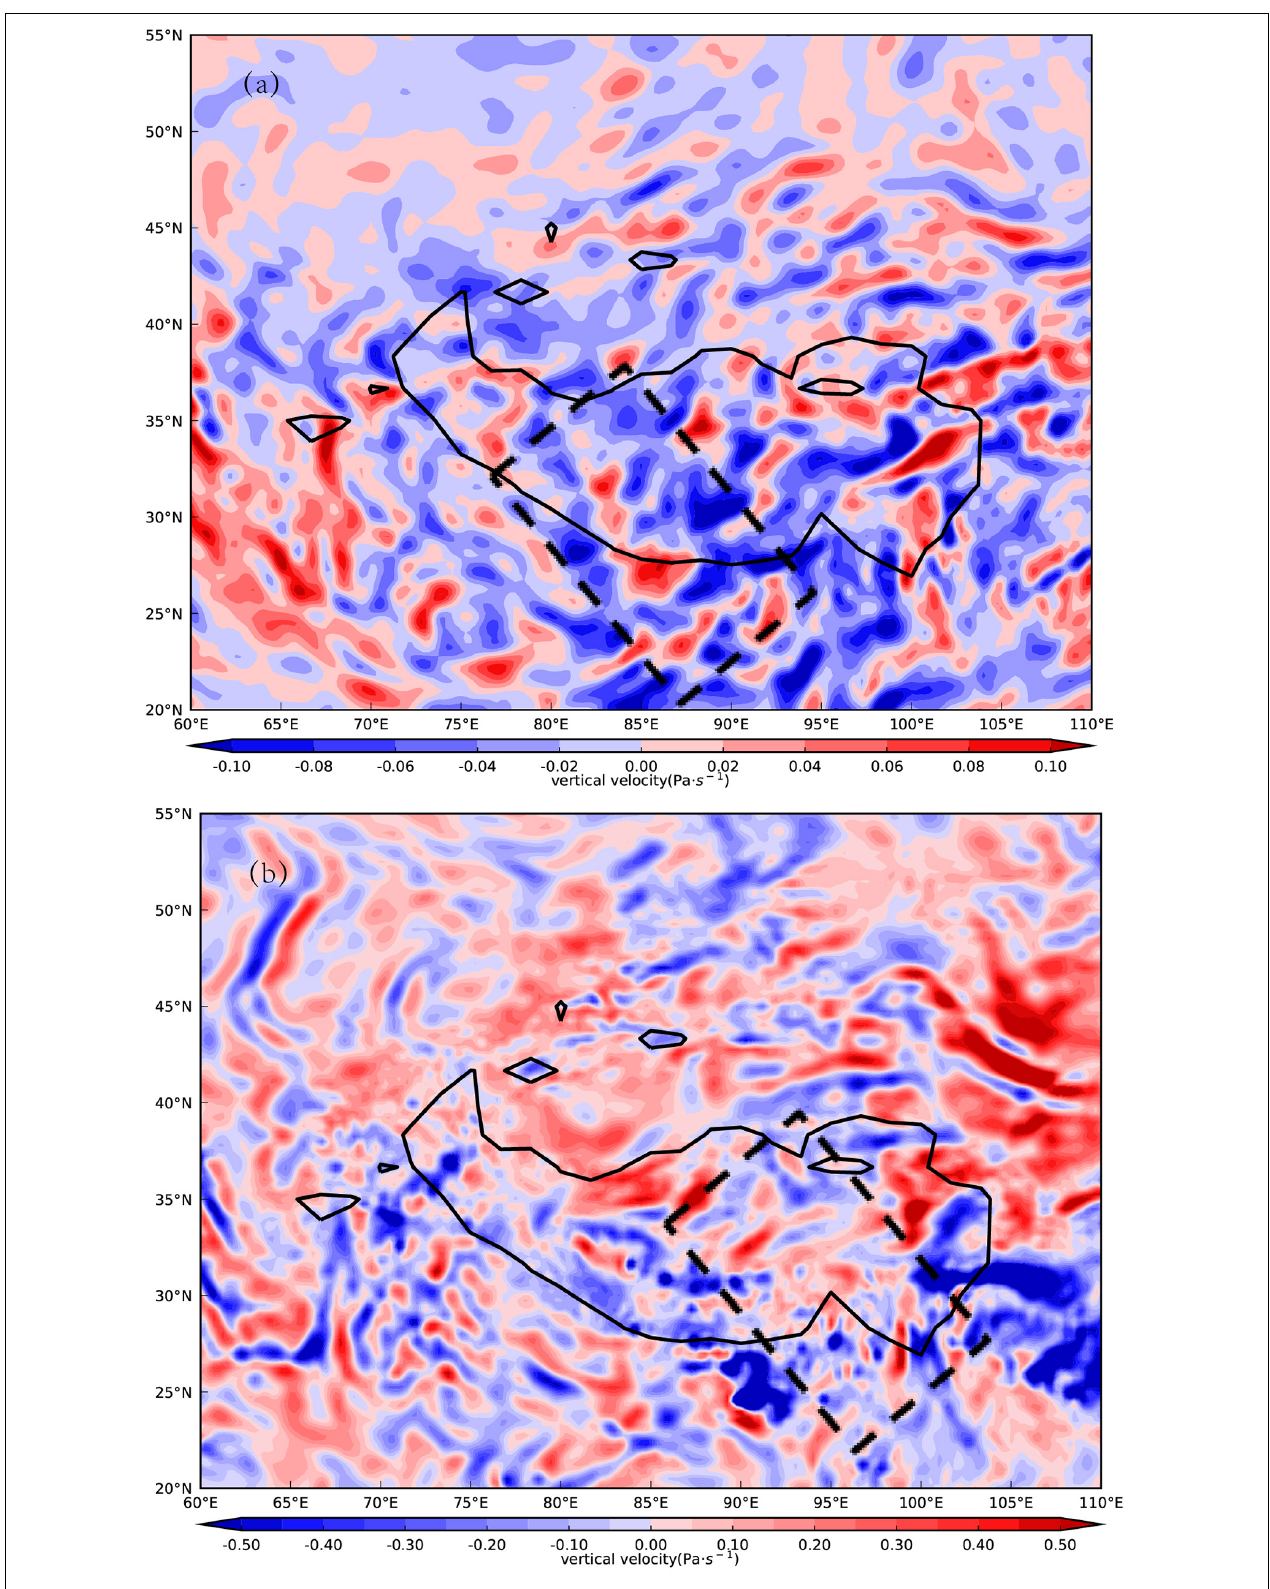
FIGURE 2 | Vertical velocity field (unit: Pa s − 1 ) at (a) 100 hPa and (b) 400 hPa from ERA5 reanalysis data at 19:00 on 3 May 2014.